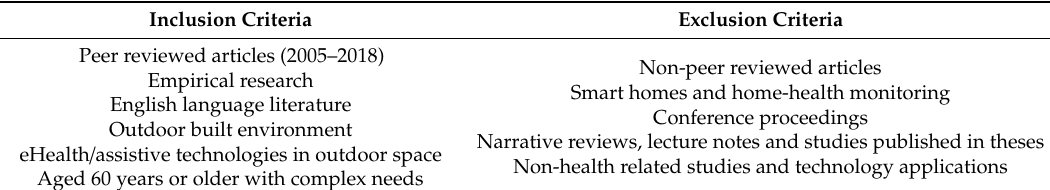
Table 1. Study inclusion and exclusion